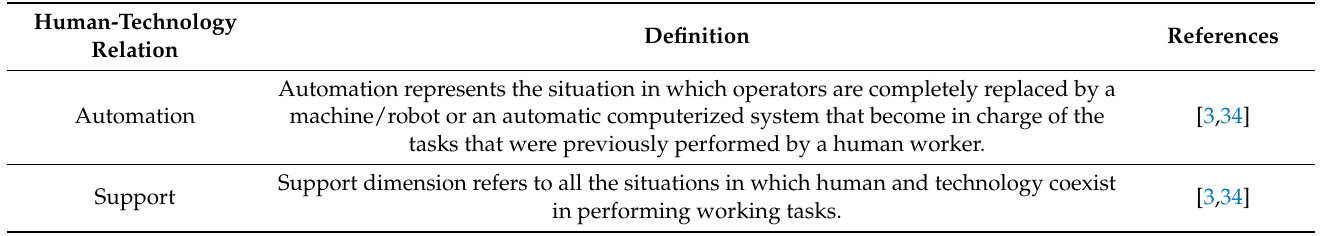
Table 3. Human–technology